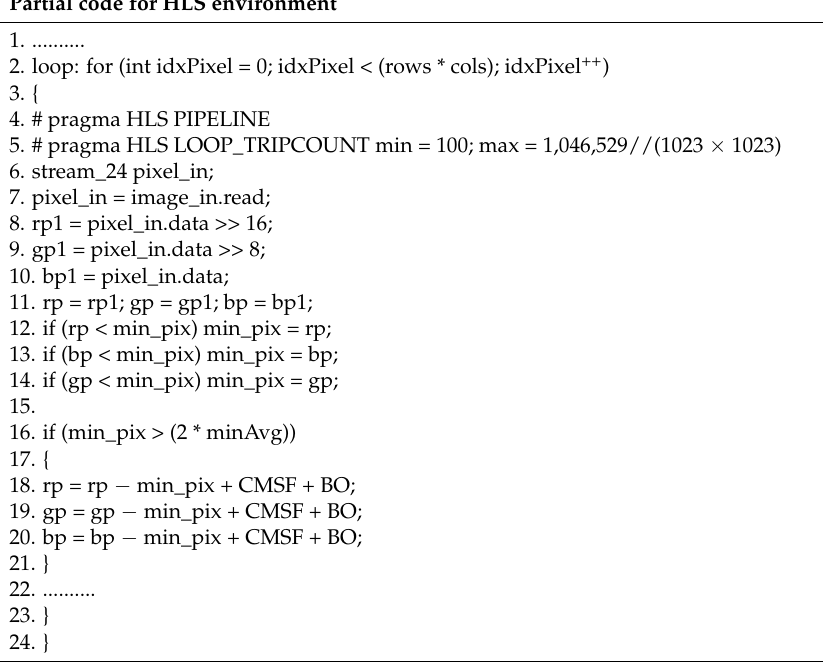
Table 2. Start of for loop, highlight detection and